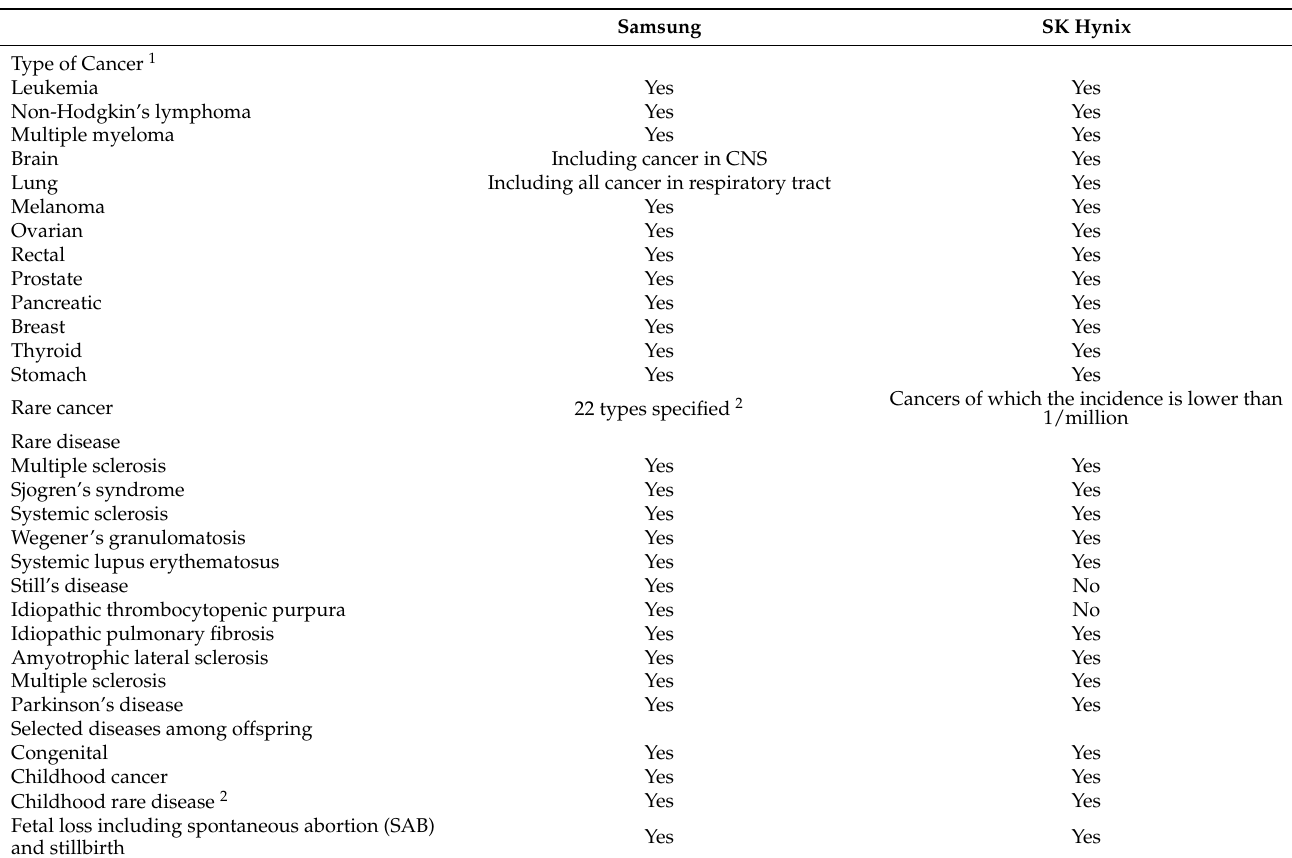
association. Table 3. Comparison of major types of cancer, rare diseases, and diseases among offspring financially supported and compensated by the two semiconductor companies as of the end of May